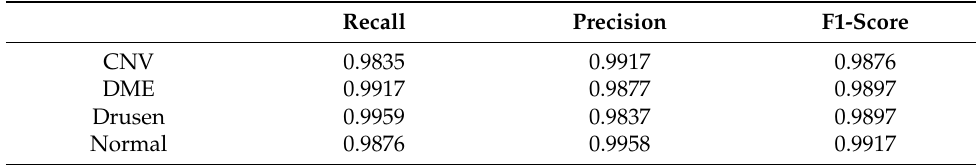
Table 7. CNN model with 9 hidden hayers.